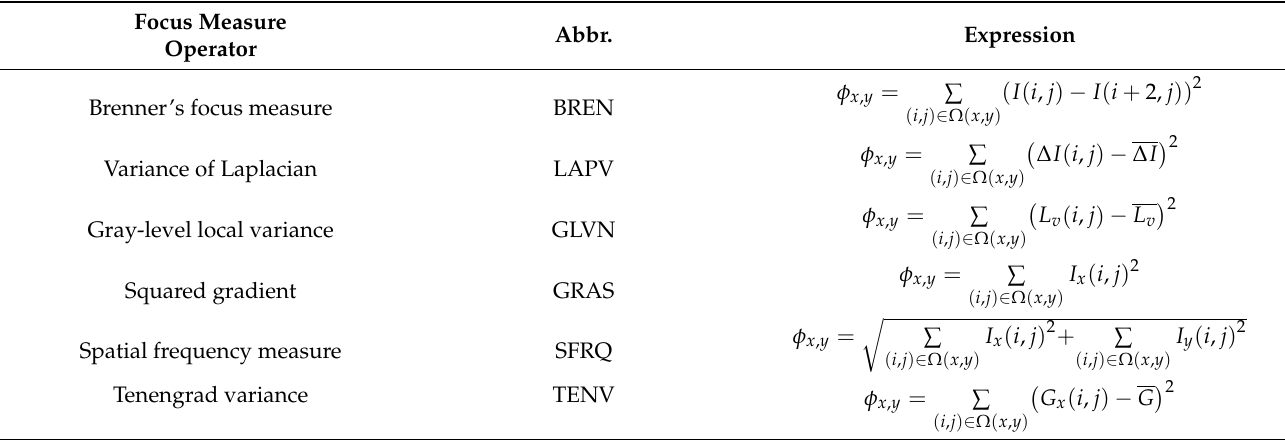
Table 1. Abbreviations for different focus measure operators.